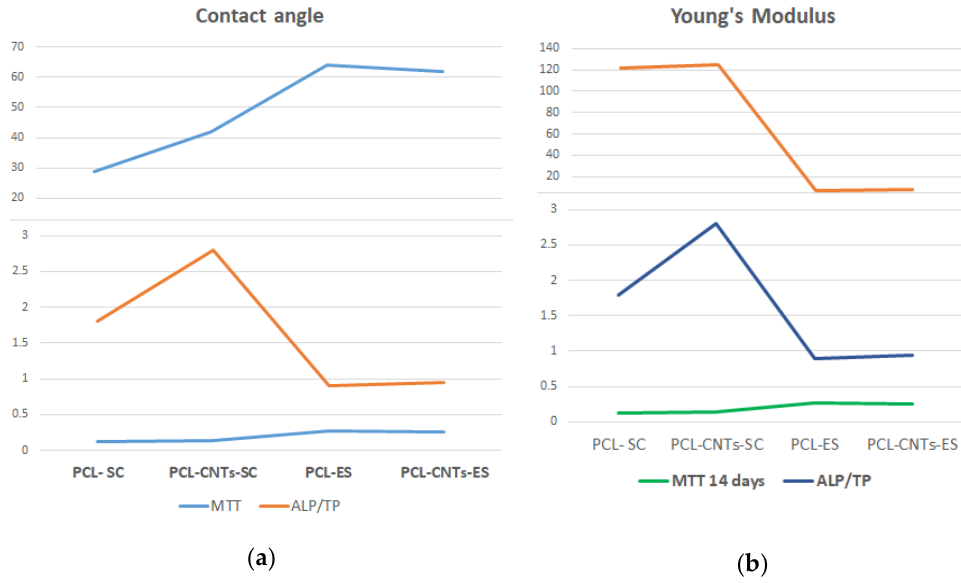
Figure 12. Values of ( a ) contact angle (blue line), MTT (green line), and ALP/TP (orange line) for the four manufactured substrates and titanium and ( b ) Young’s modulus (orange line) for the four manufactured substrates together with MTT (green line) and ALP/TP (blue